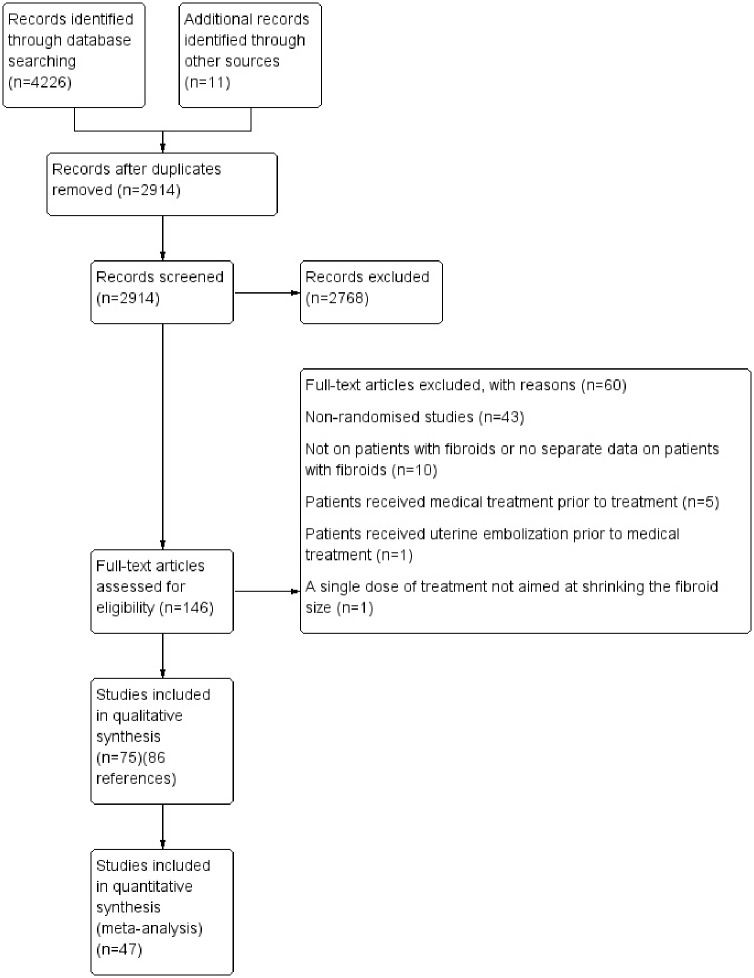
Reference flow diagram.